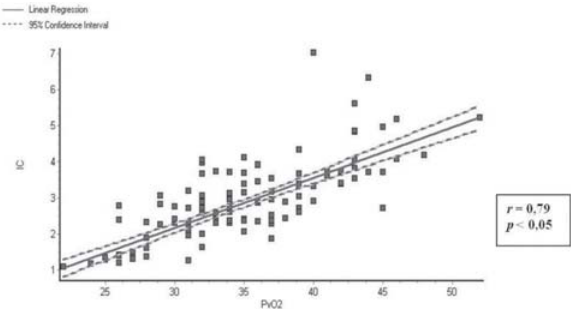
Fig. 2 - Tempo de Internação na UTI no PO por paciente